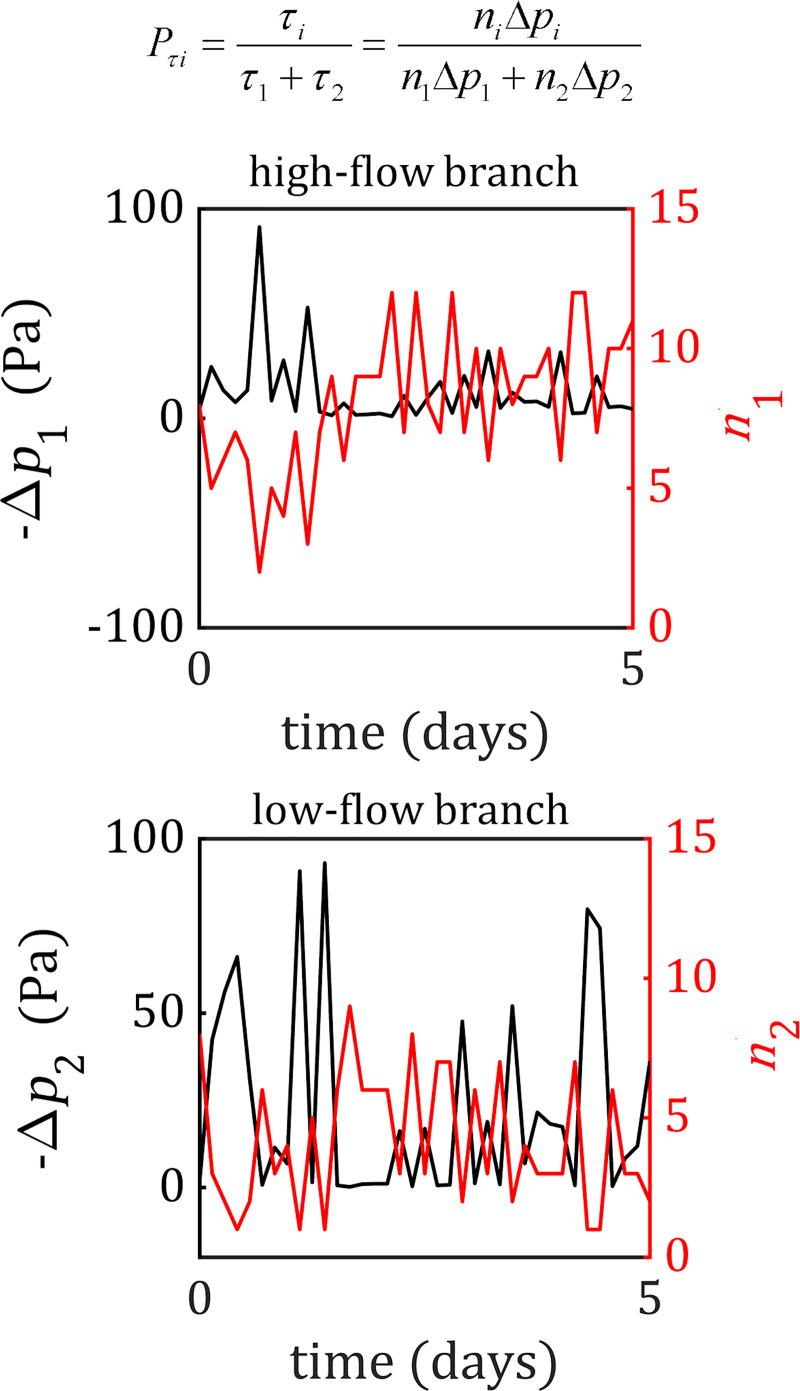
The competition between shear stress and junction force transmission results from the inverse relationship between cell number and flow resistance.The shear stress ratio within each vessel can also be expressed as a multiplicative combination of the cell number and pressure drop over the vessel. If we monitor cell number (red) and the pressure drop (black) in both the high-flow (top) and low-flow (bottom) vessel, we find that these two quantities are inversely correlated. Drops in the cell number are accompanied by spikes in the pressure drop and shear stress, as the narrowing of the vessel increases its resistance to flow. Similarly, increases in cell number result in a drop in resistance and the pressure drop, which decreases the amount of shear stress present in the vessel.